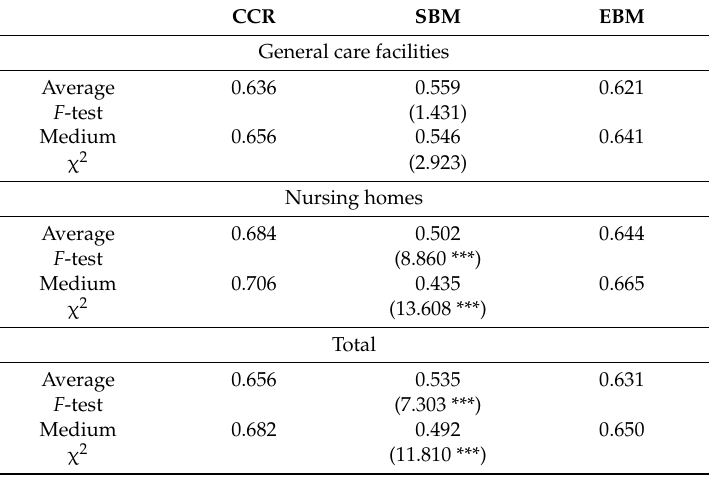
Table 6. Comparisons of CCR, SBM, and EBM DEA